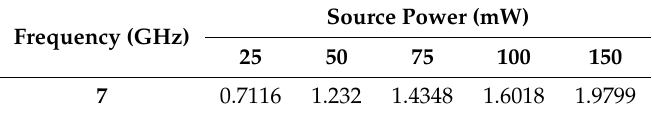
Table 3. Simulated specific absorption rate (SAR) values for different source power inputs.